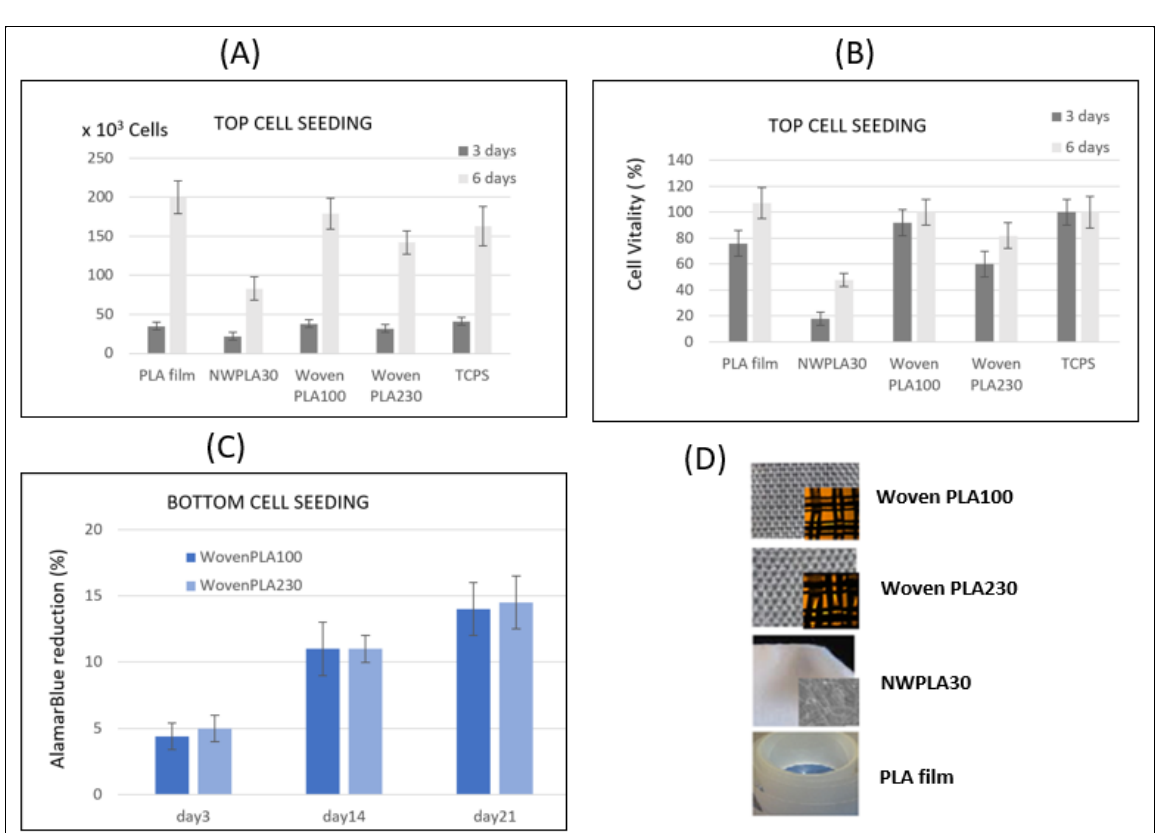
Figure 6. MG 63 osteoblast cell growth on different PLLA scaffolds. ( A , B ), after 3 and 6 days of culture for cell seeding with 6 × 10 3 cells carried out on top of scaffolds expressed as the number of adhering cells — ( A ) and as Cell vitality (using AlamarBlue ® ) with respect to TCPS controls (100%) — ( B ); ( C ) after 3, 14, and 21 days of culture for cell seeding with 4 × 10 3 cells carried out under the woven PLLA samples: cell growth and proliferation were assessed by AlamarBlue ® reduction; ( D ) Pictures of the PLLA scaffolds tested- two woven scaffolds WovenPLA100 and WovenPLA230 made from nanostructured PLLA filaments, and a nonwoven scaffold NWPLA made from a smooth 30 µm diameter filament, and a PLLA film.